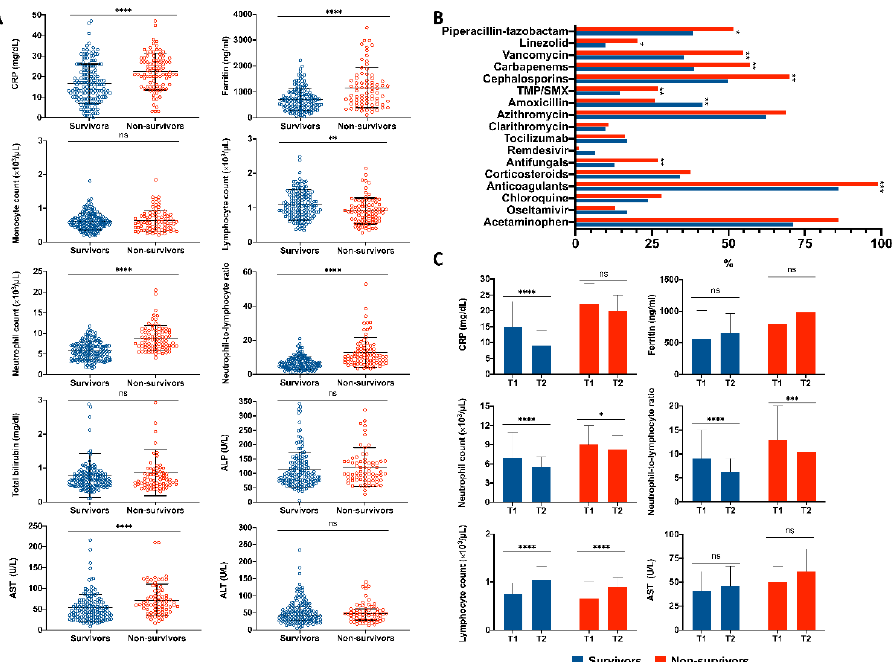
Figure 2. Laboratory parameters and treatment of COVID-19 patients evaluated during hospitalization. ( A ) Serum levels of laboratory parameters and its distribution in survivors and non-survivors. Data are presented as median with IQR, two-tailed Mann–Whitney U test was performed ( B ) Therapeutic treatment among COVID-19 patients and its frequency between survivors and non-survivors. ( C ) Time-dependent changes in CRP, Ferritin, neutrophil count, Neutrophil-to-lymphocyte ratio, lymphocytes and AST between survivors and non-survivors. T1: admission data and T2: hospitalization. Wilcoxon-signed rank test was performed. C-reactive protein, CRP; alkaline phosphatase, ALP; aspartate aminotrans- ferase, AST; alanine aminotransferase, ALT. **** p < 0.0001, *** p < 0.001, ** p < 0.01, * p < 0.05, ns: no statistical